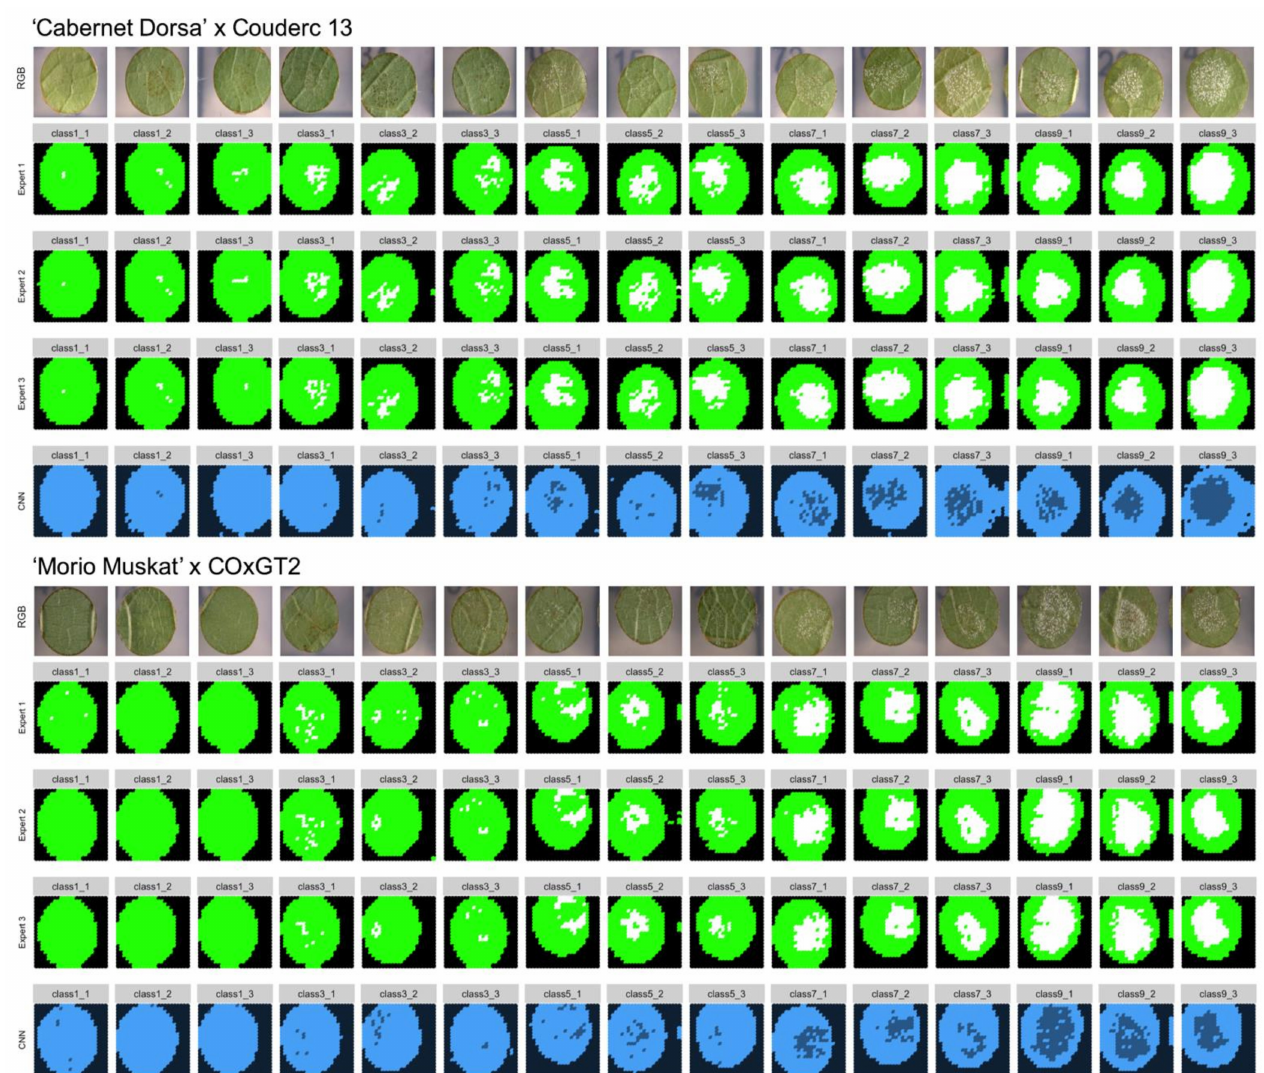
Figure 6. Original leaf disc pictures from the two different segregating populations together with ground truth data and the results of the CNN classification of the image slices. (black = background (1), dark blue = sporangiophores (2), light blue = no sporangiophores